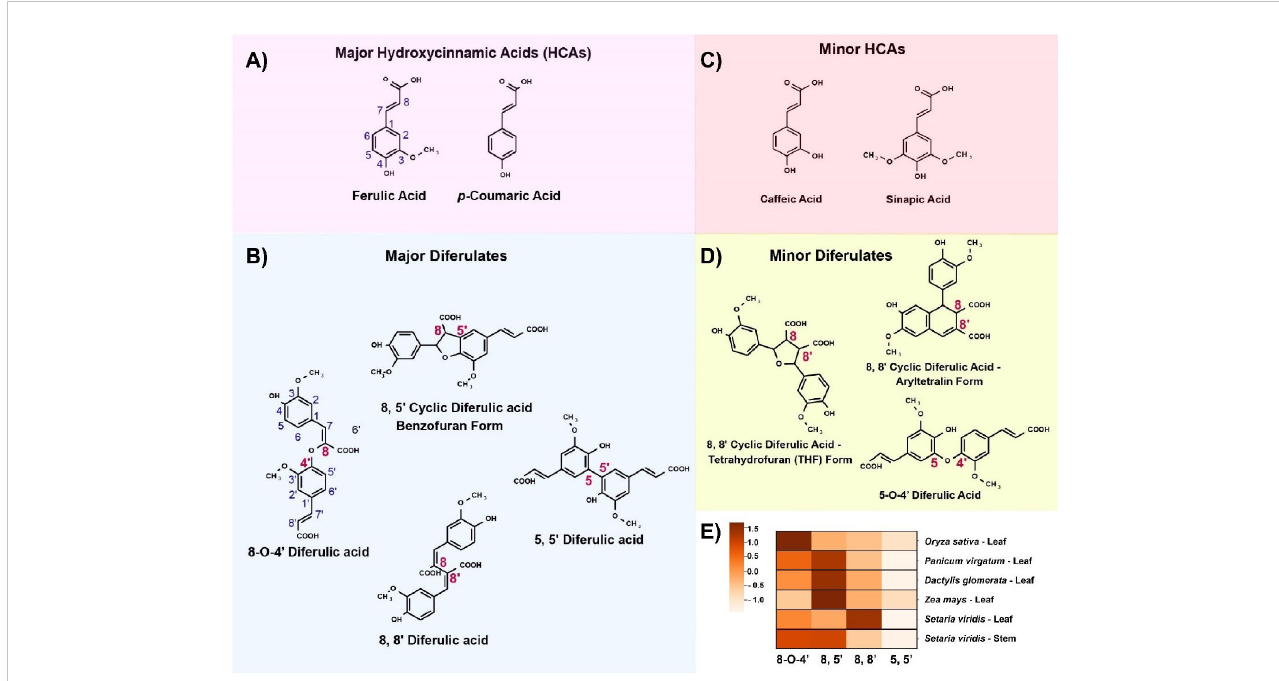
FIGURE 1 Hydroxycinnamic acid and diferulic acid structures and relative abundances. (A-D) Chemical structures of major and minor hydroxycinnamates and diferulates observed from grass cell walls. (E) Heatmap represents the relative abundances of major diferulates in Oryza sativa leaf tissue (Bartley et al., 2013), Panicum virgatum leaf, Dactylis glomerata leaf, Zea mays leaf (Hat fi eld et al., 1999), and Setaria viridis leaf and stem (de Souza et al., 2018). Relative abundances are Z-scores [(observed value – mean for a given species) /std deviation for that